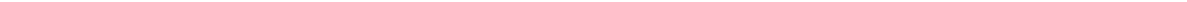
Fig. 3 VmPFC activity — experiment 2. a VmPFC activity increased at time of decision (top; cluster-corrected z > 2.3; p < 0.05; Supplementary Table 3: GLM-2, contrast 1). Activity increments were prominent in the area removed by the lesion in experiment 1 (bottom). b ROI time course illustrating the effect of decision on BOLD activity. Abscissa indicates time from decision onset and ordinate indicates beta regression coef fi cients relating the decision event to the BOLD signal. Coordinates for ROI correspond to green circle in a , top (3, 21, 3). ( c ) Left panel: estimates of each option ’ s value in each individual animal (M1 – M4) and c Right panel: normalized choice values used in two GLM analyses of experiment 2. However, from left panel c it is clear that, prior to normalization, chosen values are usually higher than unchosen values. d Activity in vmPFC (1, 17, − 2) covaried with the decision variable guiding choices — difference in subjective value (rather than objective reward amount) between choice taken and choice rejected (chosen value-unchosen value; cluster-corrected z > 2.3; p < 0.05 within 25 mm sphere centered on decision effect in a ). The regression coef fi cients relating the BOLD signal to the difference between chosen and unchosen options at the time of choice is plotted in e and regression coef fi cients relating the BOLD signal to the value of the chosen option and the unchosen option are plotted separately in f . Dif fi culty increased, and vmPFC activity increased, when the chosen value was lower or the unchosen value was higher as shown in e and f . g Full summary of lesion location ( fi rst row) and of all activity in the frontal lobe positively and negatively related to taking a decision (second row: non-cluster-corrected results; third row: cluster-corrected results) and the decision variable used to guide the decision (chosen – unchosen option value difference; fourth row: non-cluster-corrected results; fi fth row: cluster-corrected results). In summary, the results shown in a and d are representative of the pattern of activity found in adjacent regions and no negative decision-related activity and no